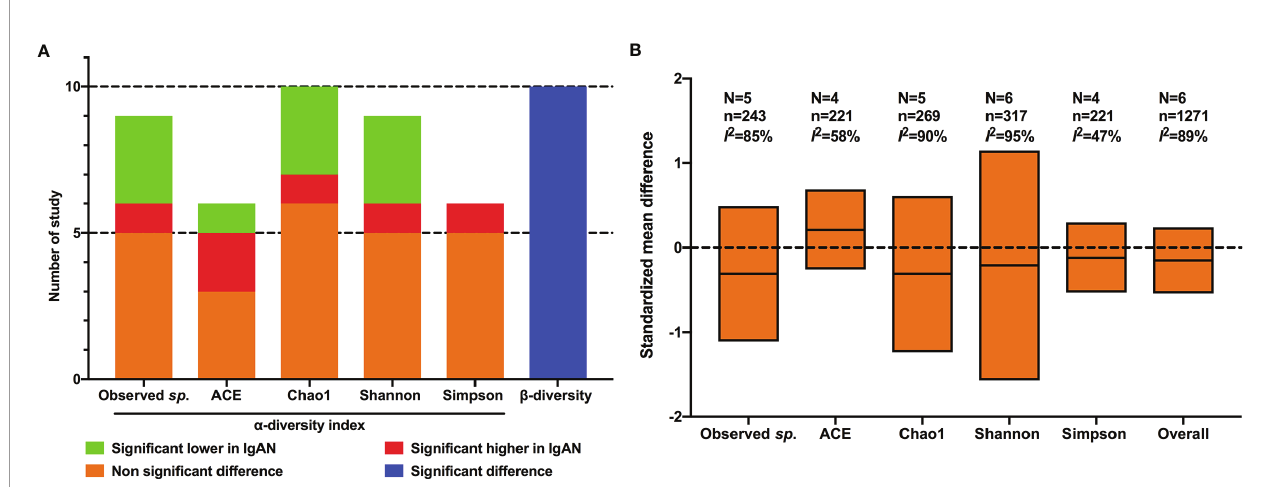
FIGURE 2 | Qualitative analysis and meta-analysis of alpha- and beta- diversity of gut fl ora between IgAN and healthy control. (A) qualitative analysis; (B) meta- analysis; N, number of studies; n, number of